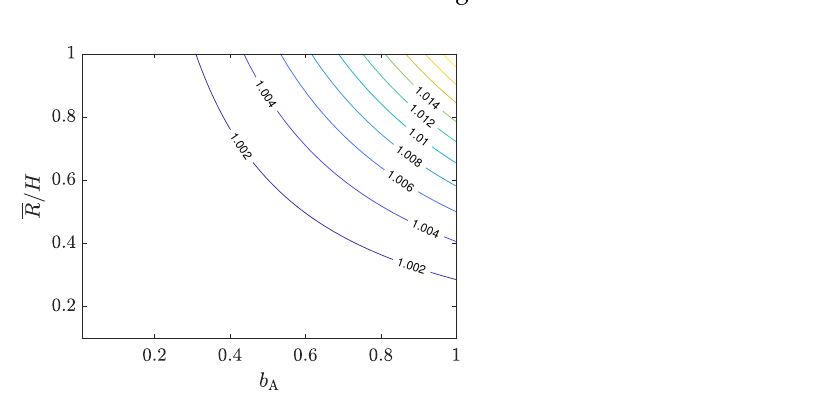
Figure 2. The ratio of Equation (4) (A-CPM) to Equation (2) (Avitzur model) for a wide range of b A and R / H